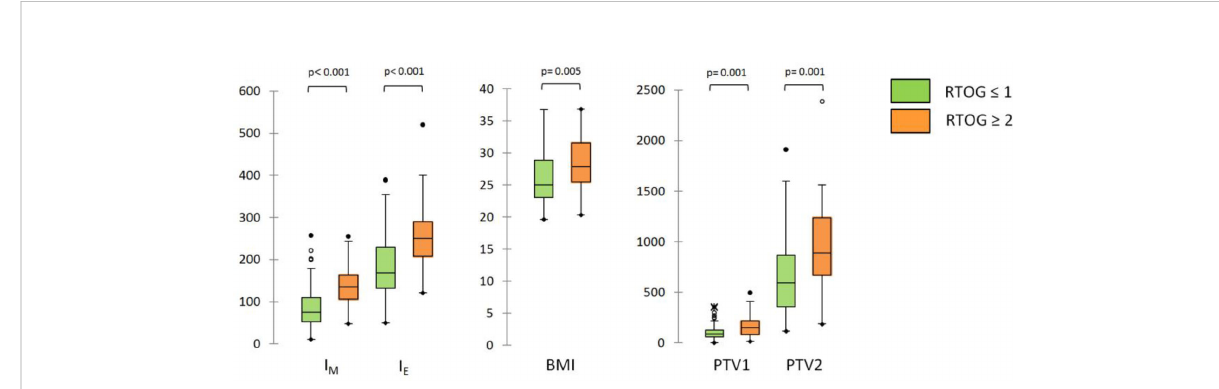
FIGURE 3 Box-and-whisker plots for I M,T0 , I E,T0 and the three continuous variables (BMI, PTV1 and PTV2) associated with RTOG toxicity classi fi cation at univariate analysis.